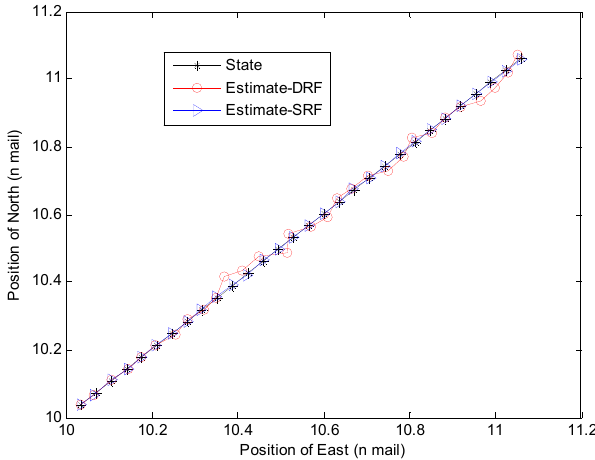
Figure 3. The target ship position state and its estimates by the two approaches.